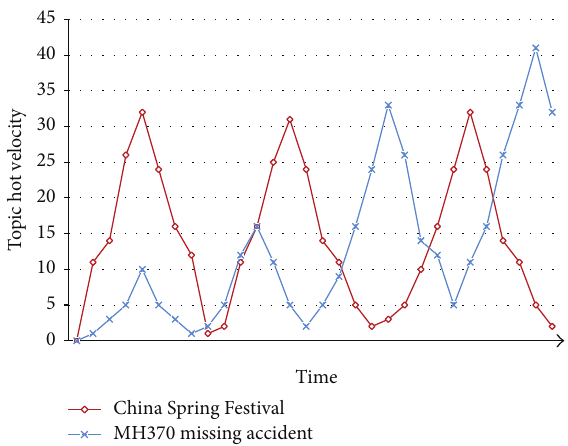
Figure 5: Topic trend with hot velocity in life